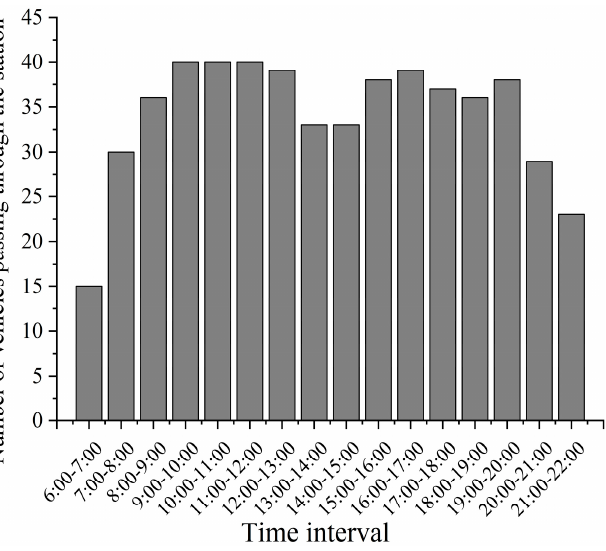
Figure 16. Number of times BRT vehicles pass analysis station in 1 day.